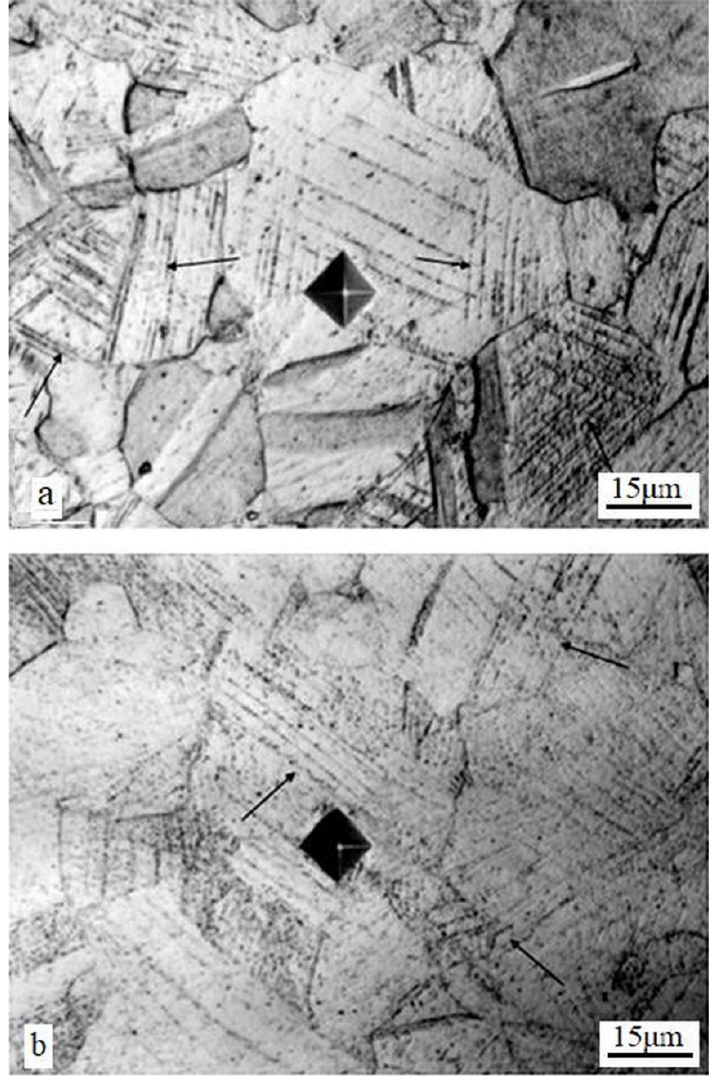
Figure 4. AISI 316L austenitic steel. Pictures from Figure 3 b and 3 f at an increased